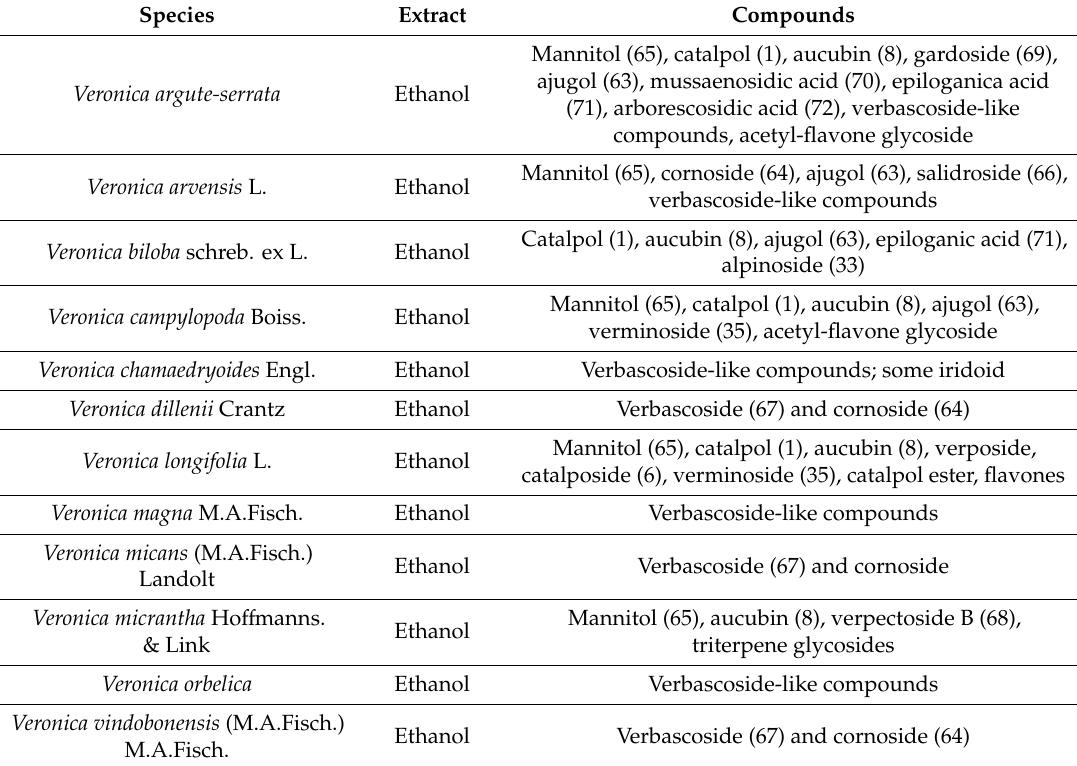
Table 2. Phytoconstituents obtained from ethanol extracts of some Veronica species (based on Reference [3]). Species